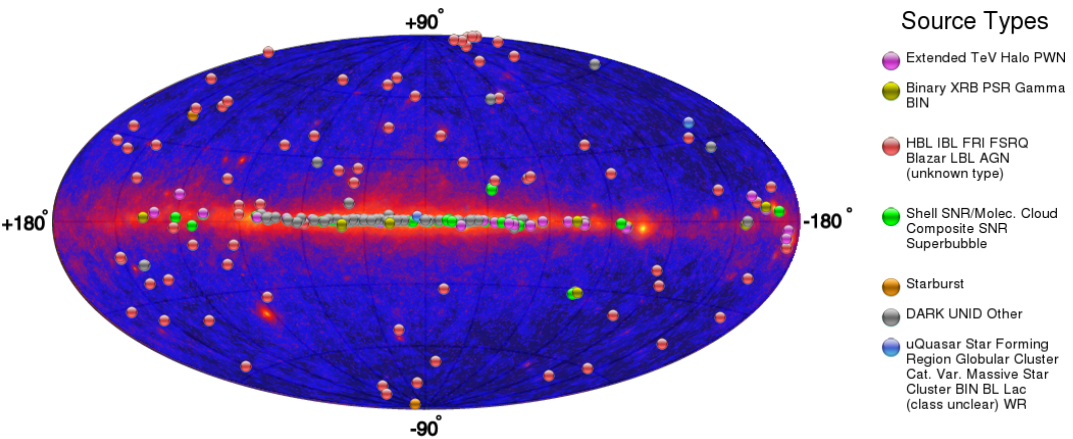
Figure 1. VHE sources listed in the TeVCat online catalog as of November 2019, here shown in Hammer-Aitoff projection and Galactic coordinates. Background is the gamma-ray sky as seen by Fermi-LAT in 4 years of operation. Note the higher density of sources, in particular of unIDs, along the Galactic plane. The figure was generated with the TeVCat online tool